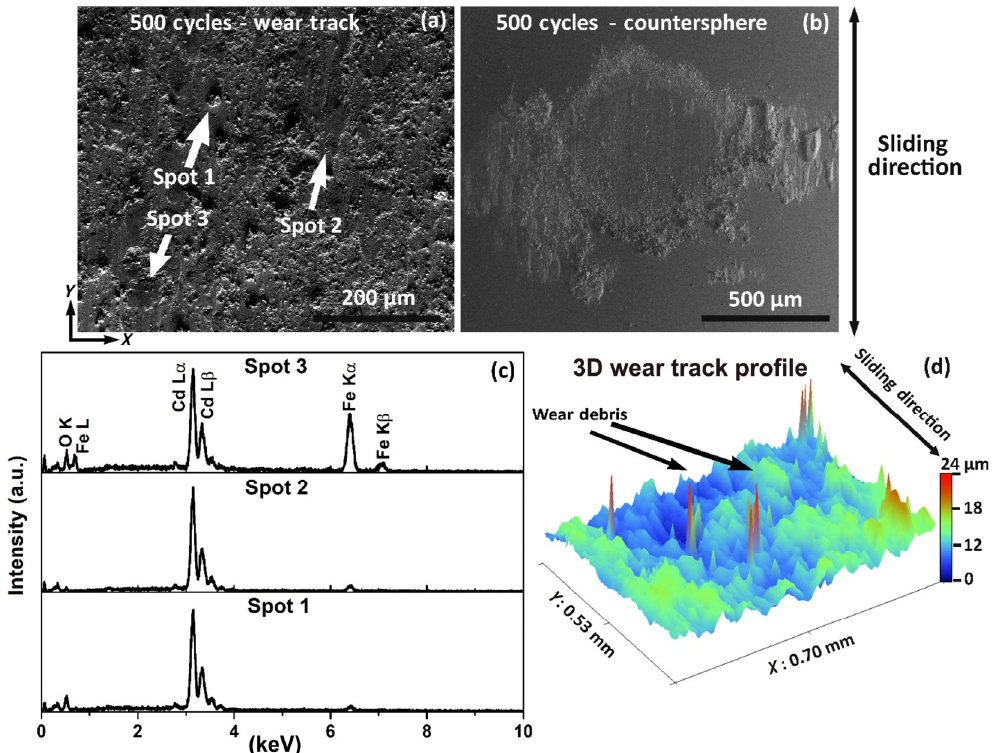
Fig. 6 (a) Wear track morphology with wear debris scattered on the wear track, (b) countersphere SEM image indicating removal of transfer film and attachment of wear debris, (c) EDS analysis of wear track showing presence of Cd and Fe substrate at different positions,